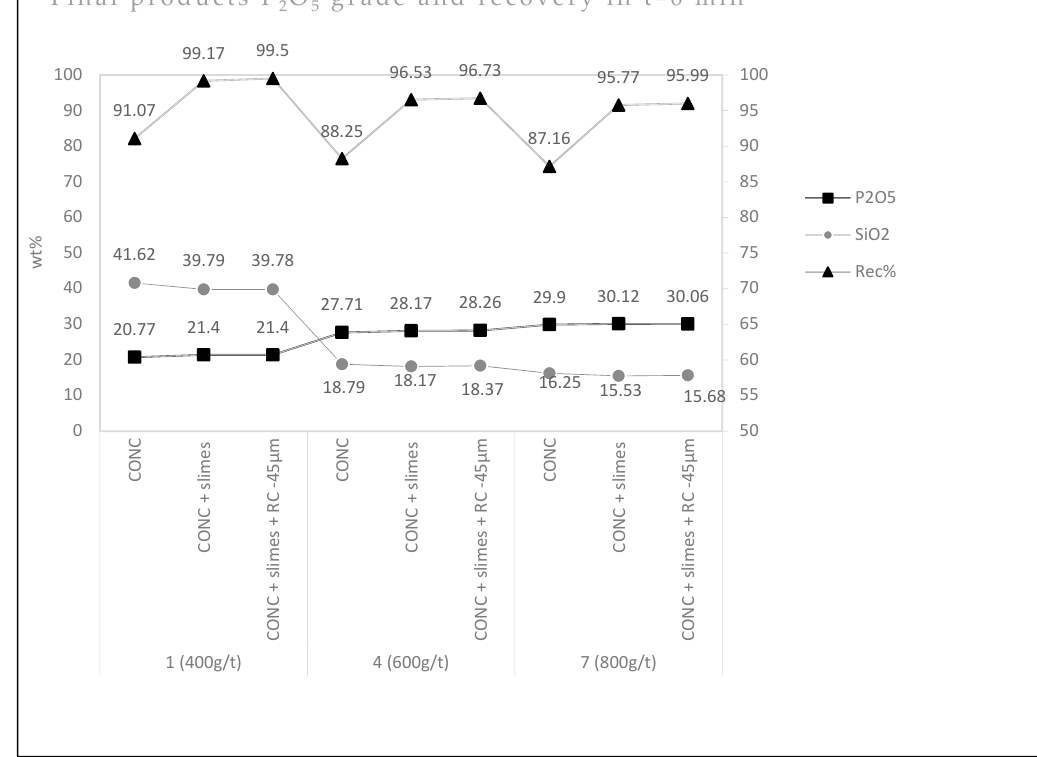
Figure 8. Grades and recovery changes in tests 1, 4, and 7 for the final product ( t = 6 min).